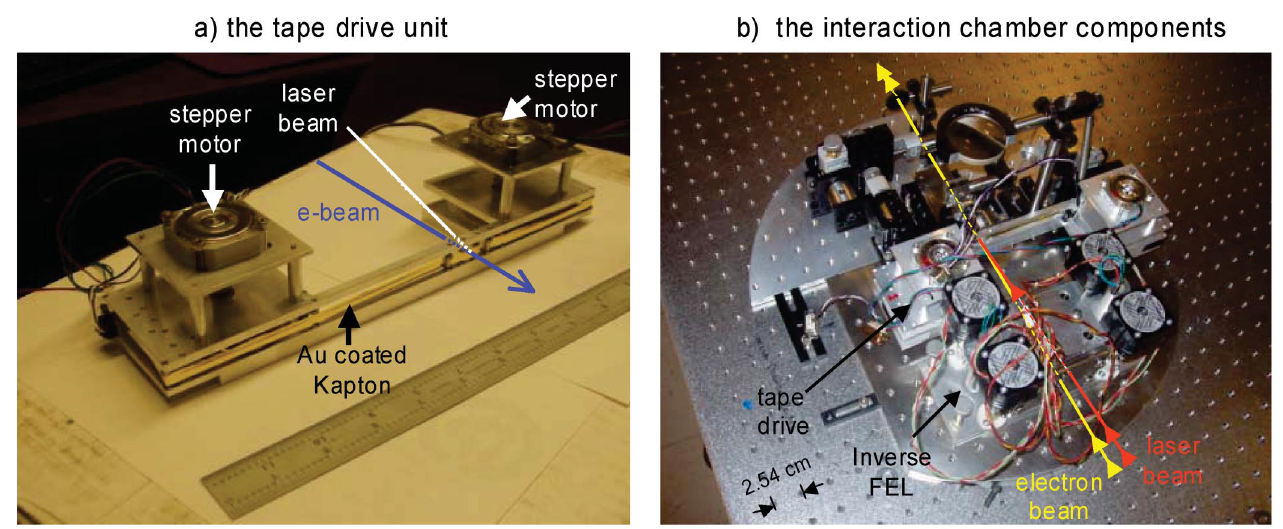
FIG. 7. (Color) (a) The tape drive for the disposable Au-coated Kapton boundary. A pair of stepper motors is used to wind the tape to either direction and a pair of opto-switches detects the end of tape. (b) The breadboard containing the vacuum chamber components, showing the IFEL and the tape drive unit located